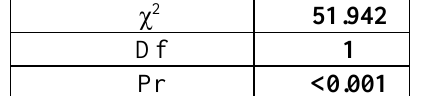
Table 9- Chi-sq test of association between the language preferred